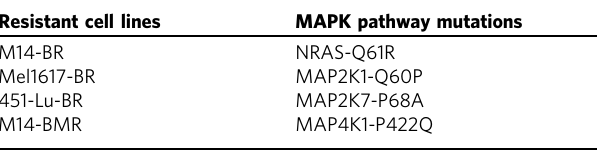
Table 1 Next-generation whole-exome